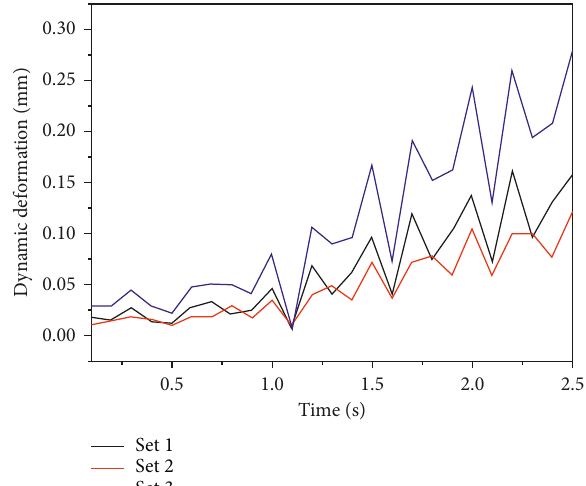
Figure 9: Time history of dynamic deformation of the observation